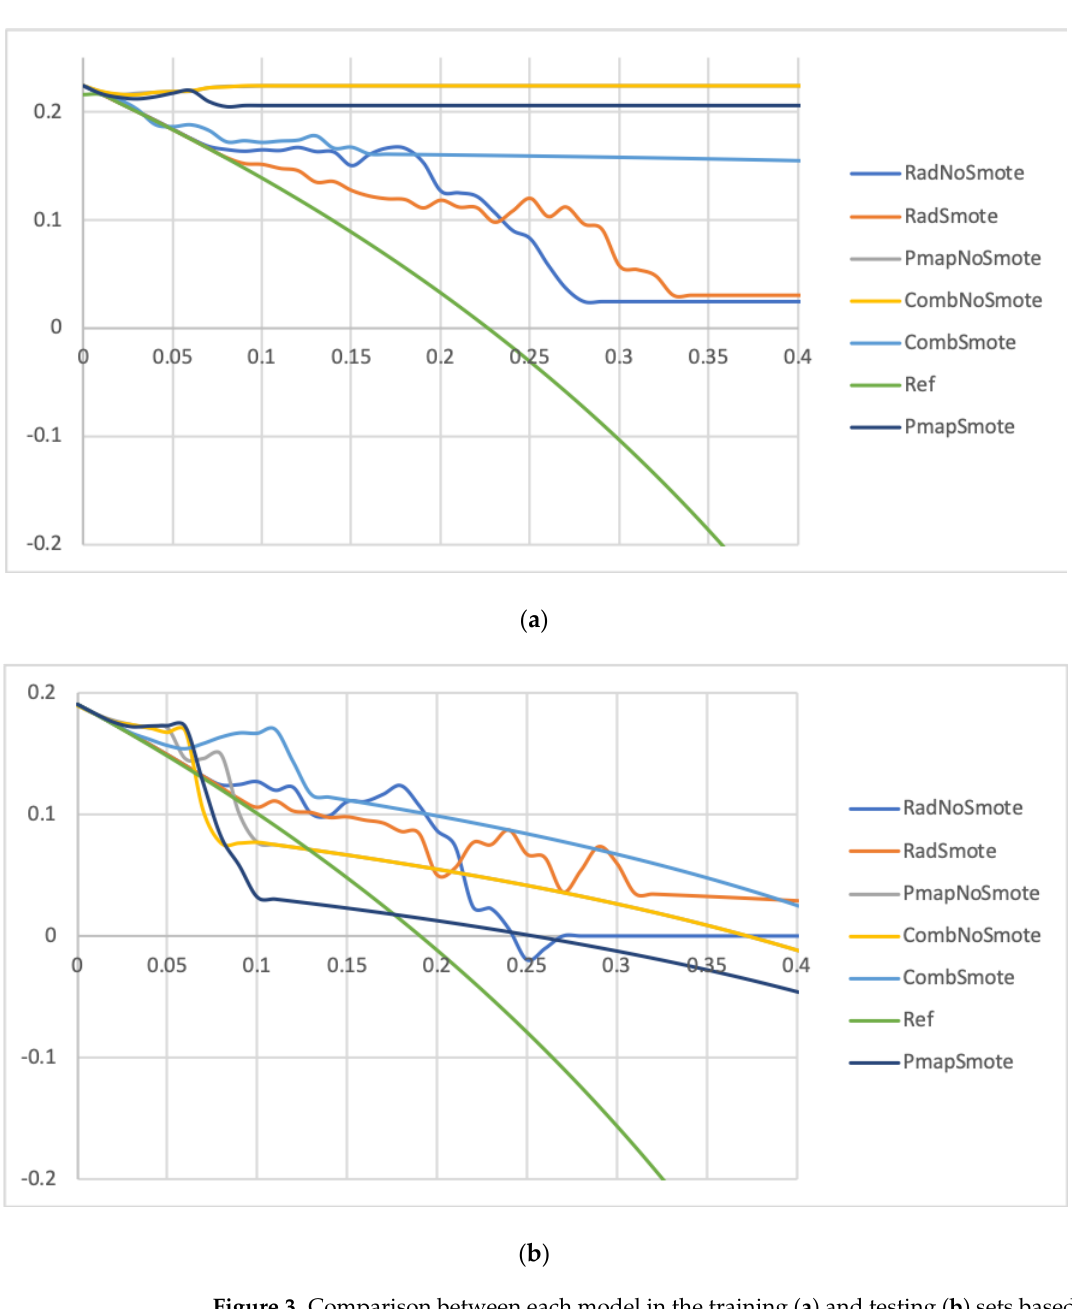
Figure 3. Comparison between each model in the training ( a ) and testing ( b ) sets based on the de- cision curve analysis for the prediction of APT ≥ grade 2. Abbreviation: APT: Acute pulmonary toxicity, Rad_NoSmote: Radiomics model without Smote, Rad_Smote: Radiomics model with Smote, Pmap_NoSmote: Pmap model without Smote, Pmap_Smote: Pmap model with Smote, Comb_NoSmote: Combined model without Smote, Comb_Smote: Combined model with Smote. Legend: x-axis: Probability threshold, y-axis: Net clinical benefit.